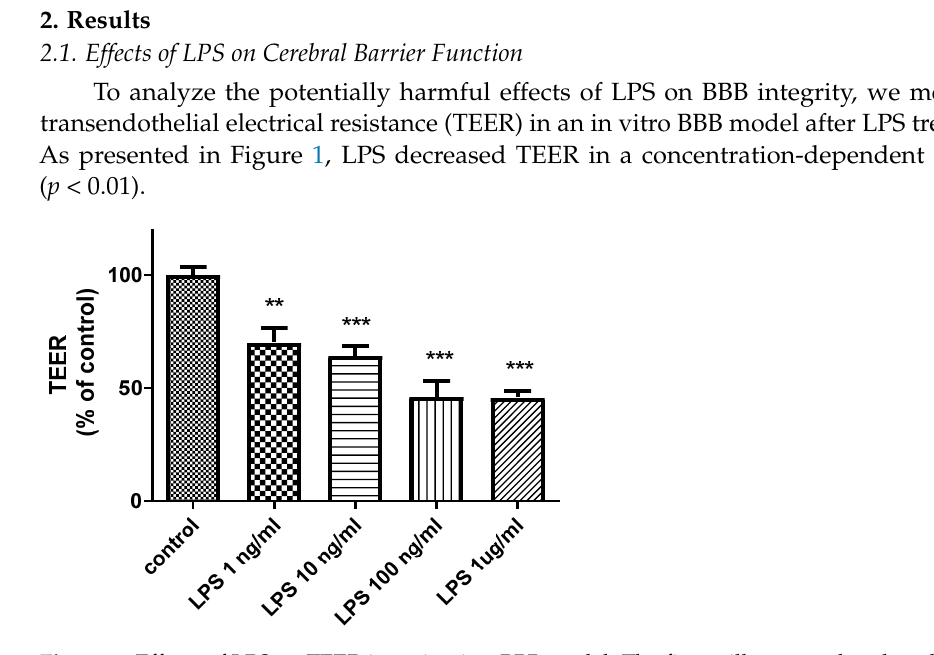
Figure 1. Effects of LPS on TEER in an in vitro BBB model. The figure illustrates that the addition of LPS to the luminal chamber of the in vitro BBB model for 24 h decreased TEER in a concentration- dependent manner. ** p < 0.01, *** p < 0.001 vs. control (one-way ANOVA, p -values were calculated from Tukey’s Multiple Comparison Test). The TEER experiment was conducted with technical replicates in triplicate experiments, n = 6 per group.